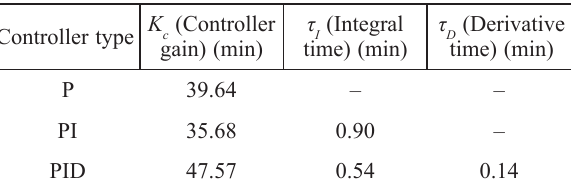
Table 5 – Settings of different controllers calculated using Ziegler-Nichols method (Controller K Controller type c gain) (min)